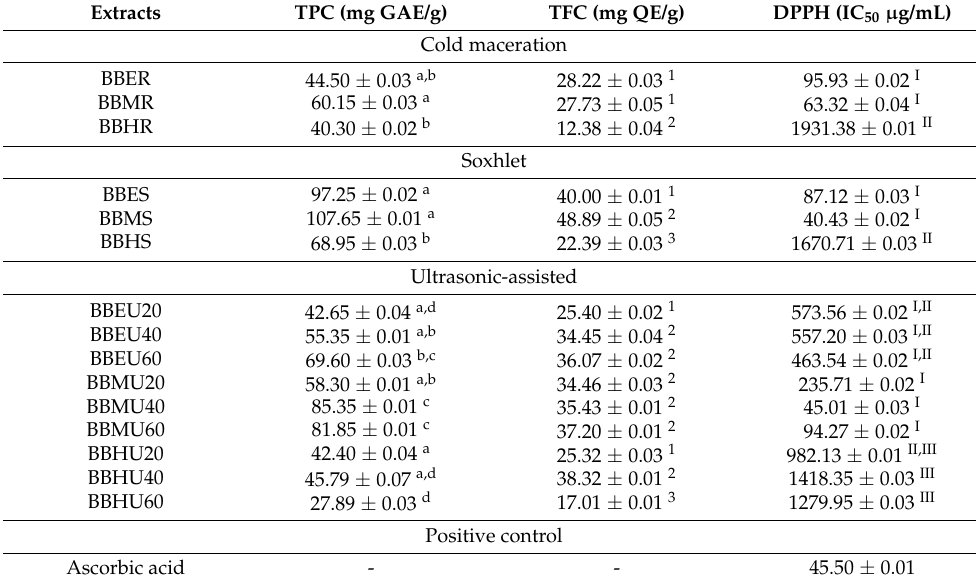
Table 3. Total phenolic and flavonoid content and DPPH scavenging activity of Bambusa beecheyana extracts using different extraction methods and